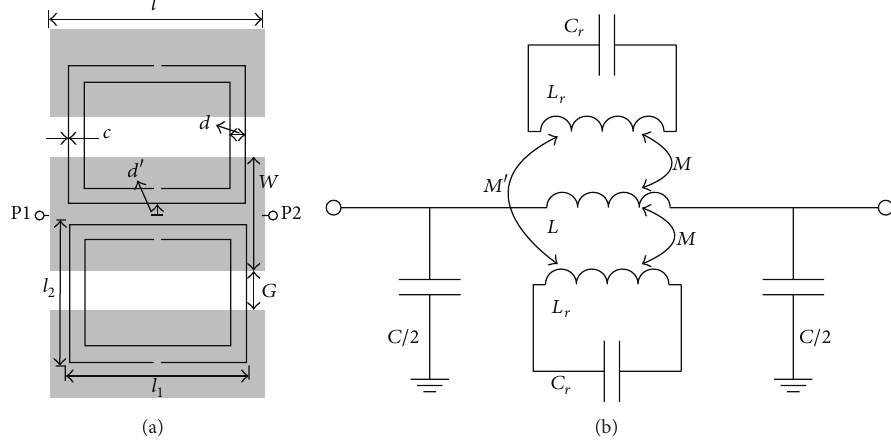
Figure 10: Typical topology of a CPW loaded with a pair of square-shaped SRRs (a) and lumped element equivalent circuit model considering magnetic coupling between SRRs